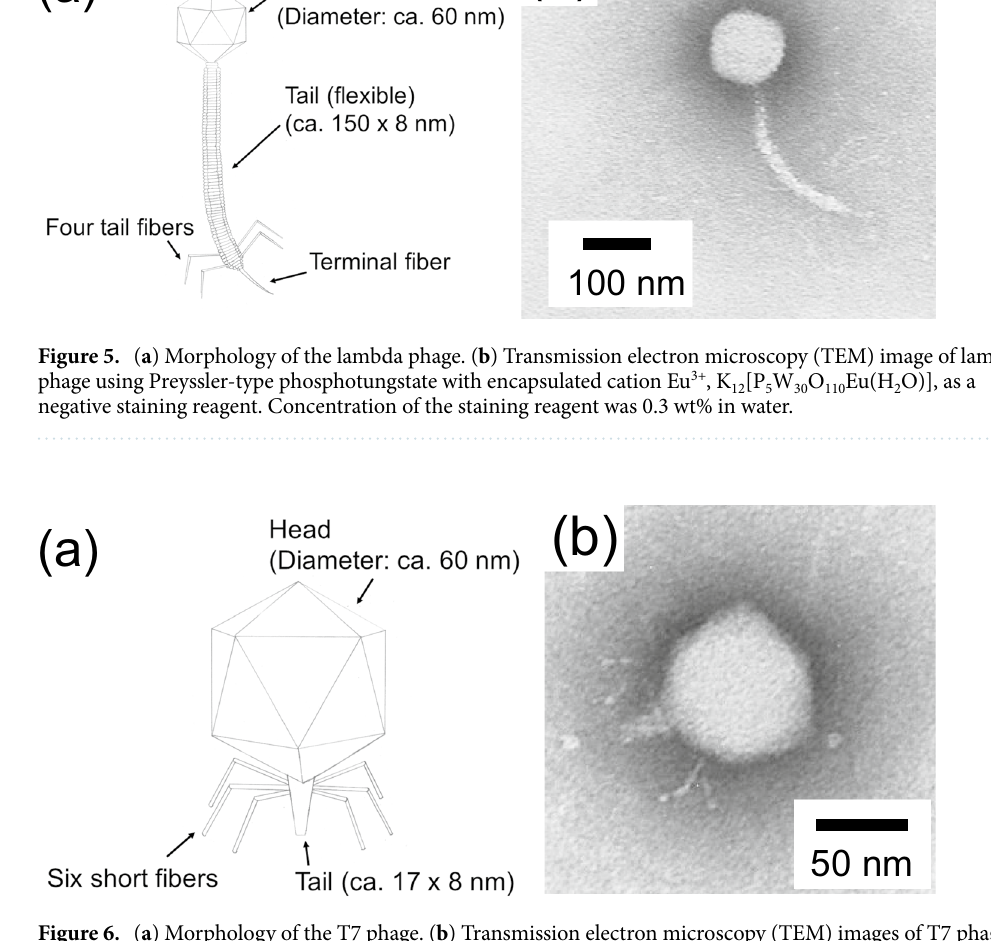
Figure 6. ( a ) Morphology of the T7 phage. ( b ) Transmission electron microscopy (TEM) images of T7 phage using Preyssler-type phosphotungstate with encapsulated cation Eu 3+ , K 12 [P 5 W 30 O 110 Eu(H 2 O)], as a negative staining reagent. Concentration of staining reagent was 0.3 wt% in